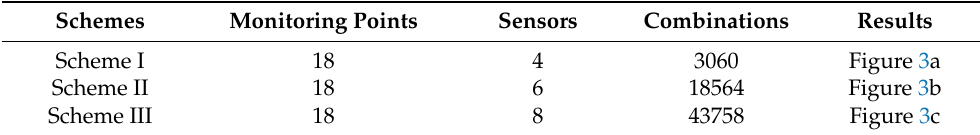
Figure 5. Comparison of optimization curves between IPSO and SA. Table 2. Comparison of the results of different network layout schemes.